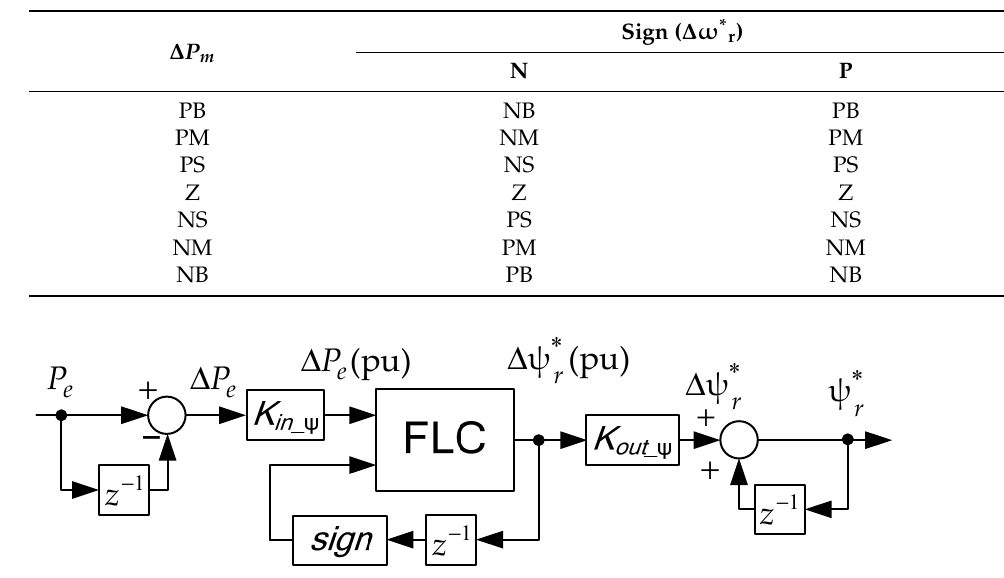
Table 1. Rule base for the fuzzy logic controllers (FLCs) in Figures 4 and 5. N, negative; P, positive; Z, zero; S, small; M, medium; B, big.